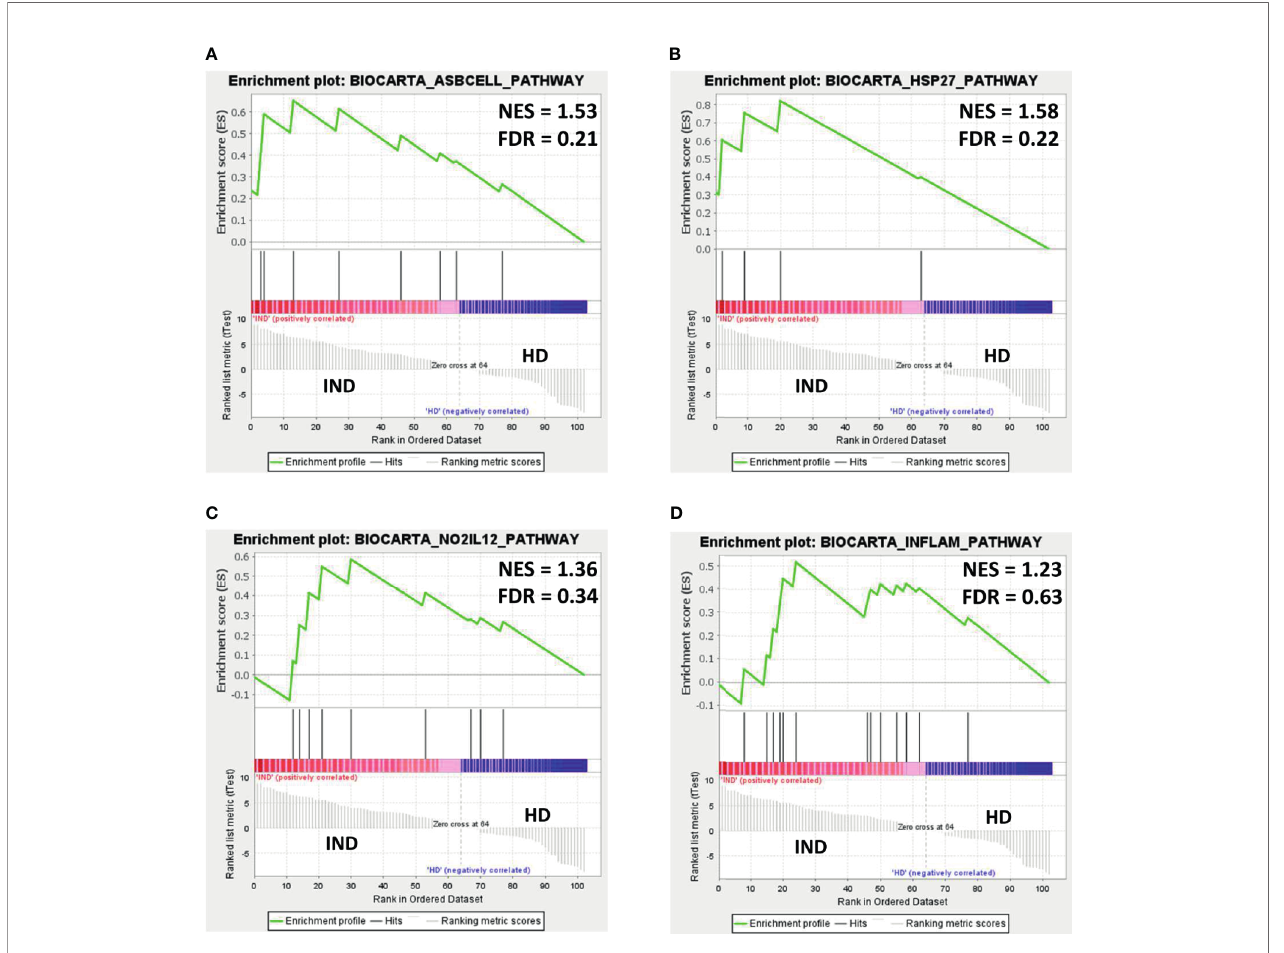
FIGURE 7 | Gene set enrichment analysis (GSEA) plots of representative gene sets from (A) antigen-dependent B cell activation pathway (BIOCARTA_ASBCELL_PATHWAY), (B) stress induction of HSP regulation (BIOCARTA_HSP27_PATHWAY, (C) NO2-dependent IL12 pathway in NK cells (BIOCARTA_NO2IL12_PATHWAY), and (D) cytokines and in fl ammatory response (BIOCARTA_INFLAM_PATHWAY) signature in IND and HD subjects. The green curve denotes the enrichment score (ES) curve. Parameters set for GSEA were as follows: Molecular Signatures Database (MSigDB) BioCarta gene set collection, permutations = 100,000, permutation type: phenotype, enrichment statistic: weighted, metric for ranking genes: t-test, max size: 500, min size: 3. NES, normalized enrichment score; FDR, false discovery rate